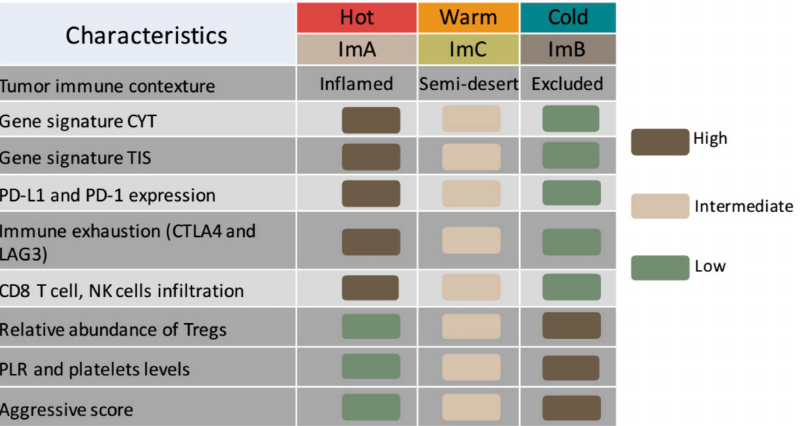
Figure 6. Each Immuno-cluster can be described as unique entity similar to cold, warm and hot immune tumors. Summary plot of the local and systemic immune characterization among the defined Im-Clus in our triple negative breast cancer (TNBC)